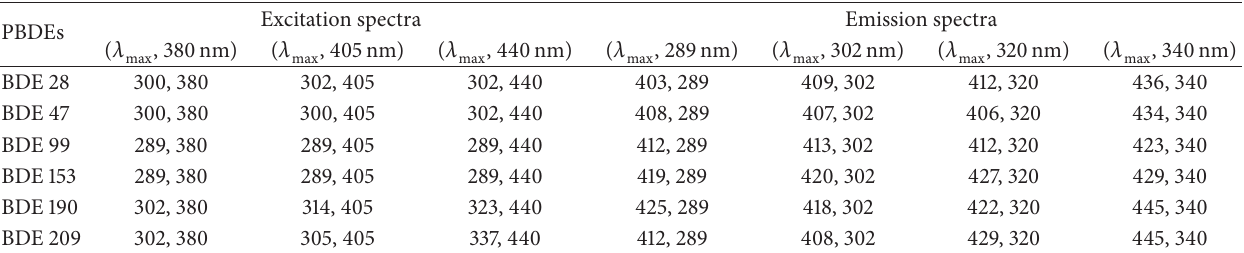
Table 1: The excitation and emission peak positions ( 𝜆 max , nm) of six single congeners of PBDEs at variable emission wavelengths ( 𝜆 380, 405, and 440 nm) and excitation wavelengths ( 𝜆